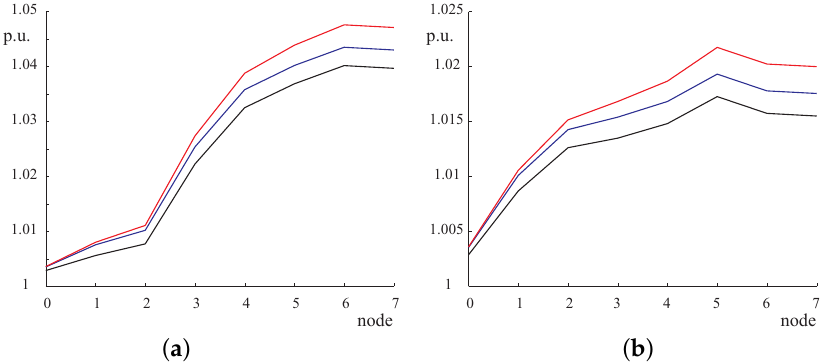
Figure 7. Voltage amplitudes in the case B for feeder 1 ( a ) and feeder 2 ( b ) evaluated by the exact load-flow (black); the proposed method (blue) and the perturb-and-observe method